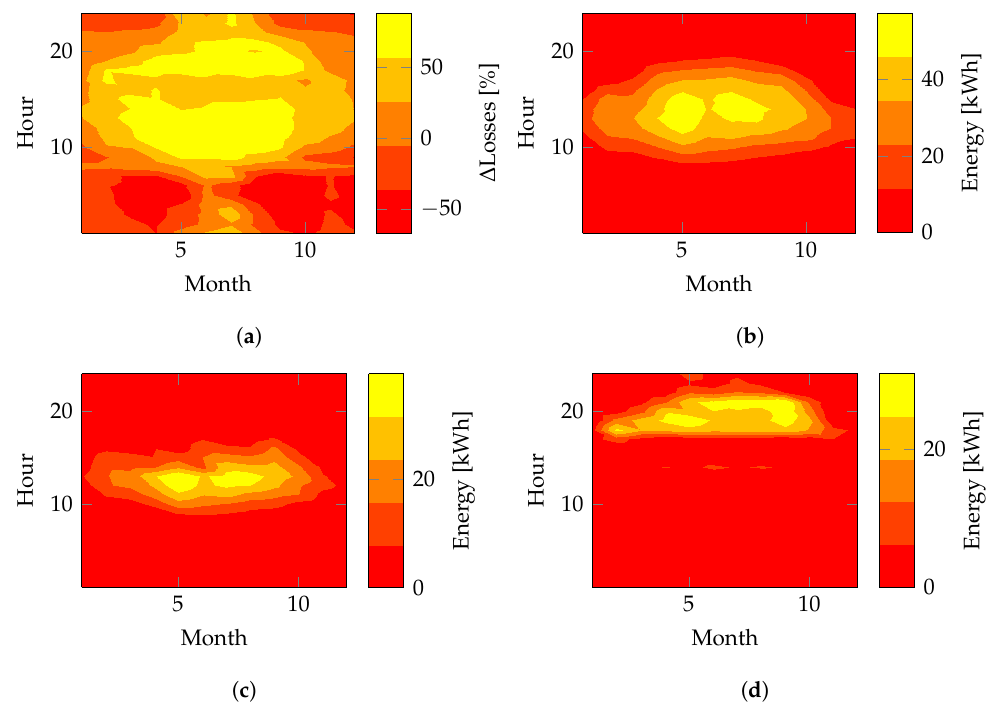
Figure 10. Heat map per daily hour and month in 2016 showing ( a ) loss differences in AC and DC operations (positive values indicate savings with DC), ( b ) accumulated PV generation, and ( c,d ) accumulated battery charge and discharge,